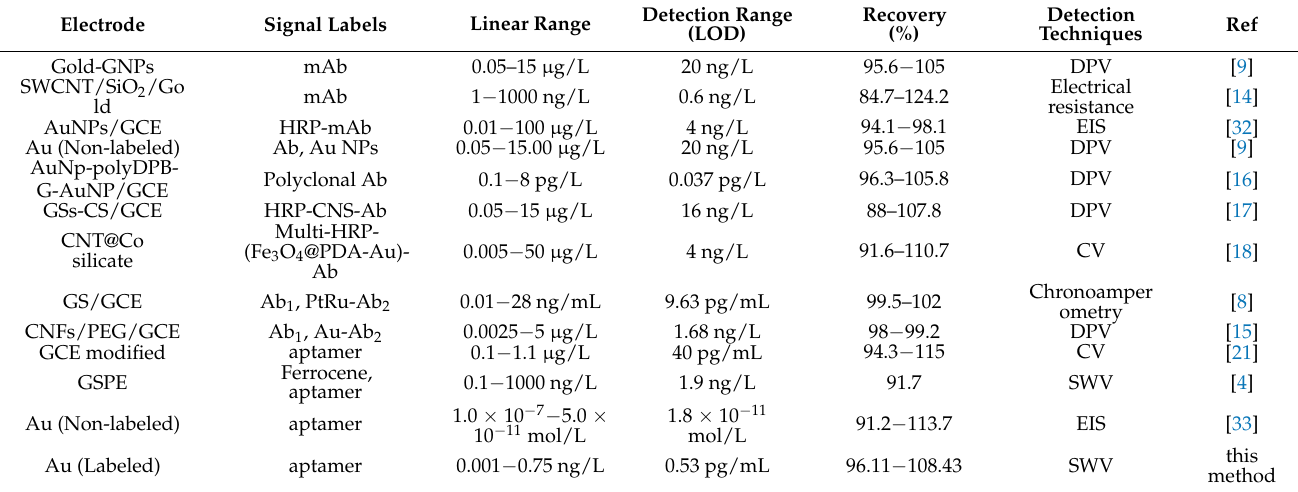
Table 1. Comparison in performance of electrochemical biosensors for detection of MC − LR.